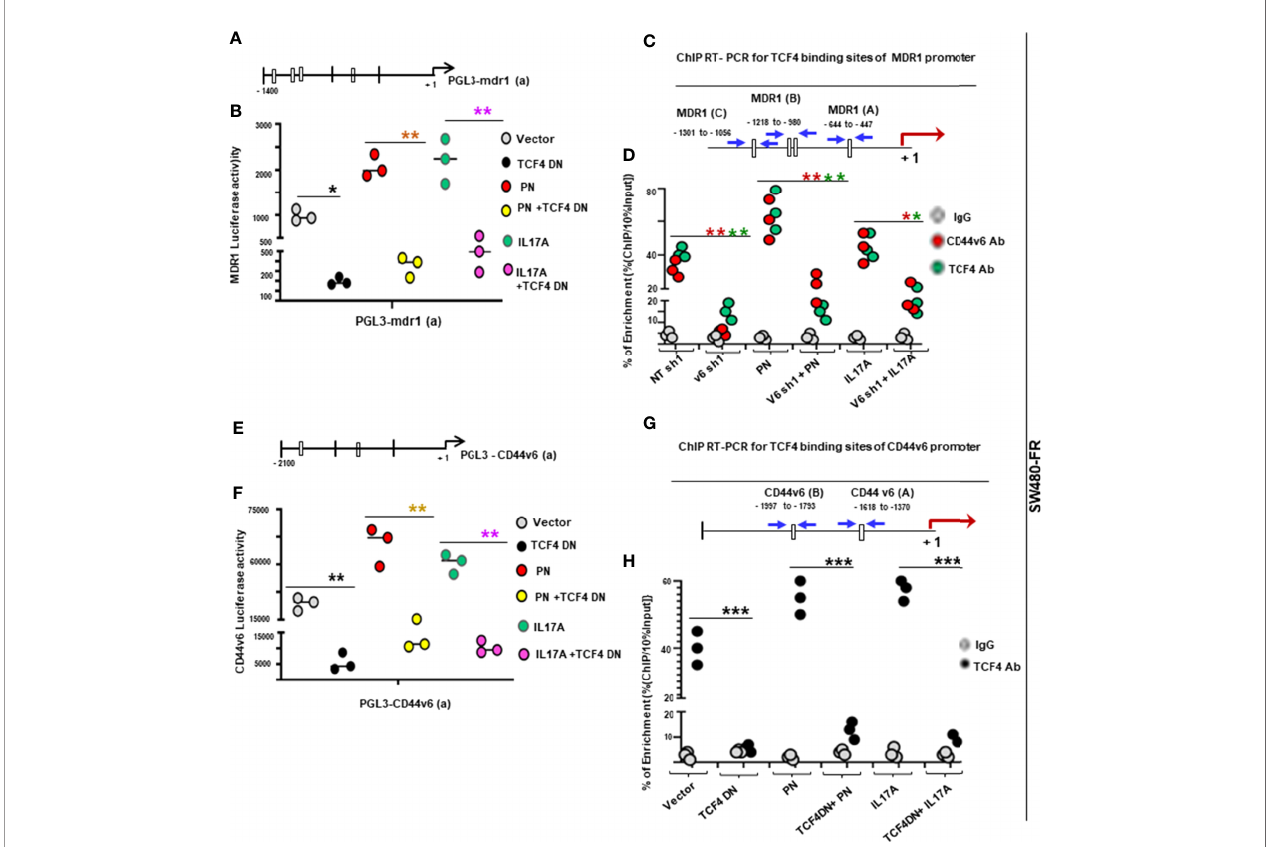
FIGURE 7 | PN and IL17A induce association of nuclear b -catenin/TCF4 with CD44v6 and MDR1 to modulate drug resistance. (A, B) , PN and IL17A induced MDR1 promoter luciferase activities were measured in SW480-FR cells using the indicated pGL3-mdr1 (a) reporter containing TCF4 binding sites (CTTTGA). (A) , The scheme shows the pGL3-mdr1 (a) reporter constructs with TCF binding sites. (B) , MDR1 luciferase activity reporter assays are shown for SW480-FR cells overexpressing a dominant negative TCF4-DN construct for 48 hours followed by co-transfection with or without PN or IL17A expression vectors. (C) , The sketch map shows the predicted TCF4 binding sites (CTTTGA) within the indicated MDR1 promoter (blue arrows). The transcriptional start site (red arrow) was at “ +1 ” , and ATG is at the translation start site. The putative TCF4 binding sites (MDR1 (A), MDR1 (B) and MDR1 (C) are shown, and their locations are labeled. (D) , ChIP PCR primers, designated for MDR1 (A) as shown in (C) , were used for ampli fi cation of the potential TCF4 binding sites of the MDR1 gene. ChIP assays were done using either anti-CD44v6, anti b -catenin or irrelevant IgG antibody as negative control in SW480-FR cells overexpressing speci fi c shRNAs against CD44v6 or Non-targeted shRNA (NT-sh) with or without co-transfection with PN or IL17A constructs. Input: total genomic DNA was used as control for the PCR. (E, F) , PN and IL17A induced CD44v6 promoter luciferase activities were measured in SW480-FR cells using the indicated pGL3-CD44v6 (a) reporter containing TCF4 binding sites. (E) , The sketch map of predicted TCF4 binding sites (CTTTGA) within the CD44v6 promoter luciferase construct (CD44v6 [a]) is shown. (F) , CD44v6 luciferase activity reporter assays are shown for SW480-FR cells overexpressing dominant negative (DN) TCF4 for 48 hours followed by co-transfection with or without PN or IL17A expression vectors. (G, H) , PN or IL17A induced CD44v6 gene expression regulated by TCF4 in SW480-FR cells is shown. (G) , The sketch map shows the predicted TCF4 binding sites (CTTTGA) within the indicated CD44v6 promoter (blue arrows). The transcriptional start site was at “ +1 ” , and ATG is at the translation start site (red arrow). The putative TCF4 binding sites [CD44v6 (A) ] and CD44v6 (B) are shown, and their locations are labeled. (H) , ChIP PCR primers, designated for CD44v6 (A) as shown in (G) , were used for ampli fi cation of the potential TCF4 binding sites of the CD44v6 gene. ChIP assays were done using either anti-TCF4 or irrelevant IgG antibody as negative control in SW480-FR cells overexpressing a dominant negative TCF4-DN construct for 48 hours followed by co-transfection with or without PN or IL17A expression vectors. Data presented in (B, D, F, H are Mean ± SD.; n = 3 – 5 independent replicates in three independent experiments; (B) , *, P < 0.05, **, P < 0.01 were considered signi fi cant, Inhibition in MDR1 luciferase activity in TCF4 DN, or PN + TCF4 DN, or IL17A + TCF4 DN overexpressed groups compared to vector control group. (D) , *, P < 0.05, **, P < 0.01 were considered signi fi cant, Inhibition of percent of enrichment of MDR1 mRNA in v6 shRNA1 (v6 sh1), v6 sh1+PN, v6 sh1+IL17A groups compared with , NT sh1, or PN, or IL17A overexpressed groups. (E) , *, P < 0.05, **, P < 0.01 were considered signi fi cant, Inhibition in CD44 luciferase activity in TCF4 DN, or PN + TCF4 DN, or IL17A + TCF4 DN overexpressed groups compared to vector control group. (F) ,